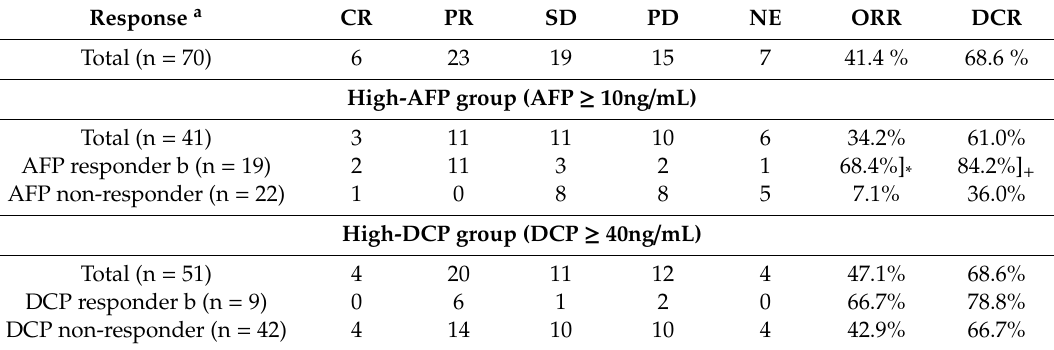
Table 2. Relationship between treatment response and response of tumor markers.